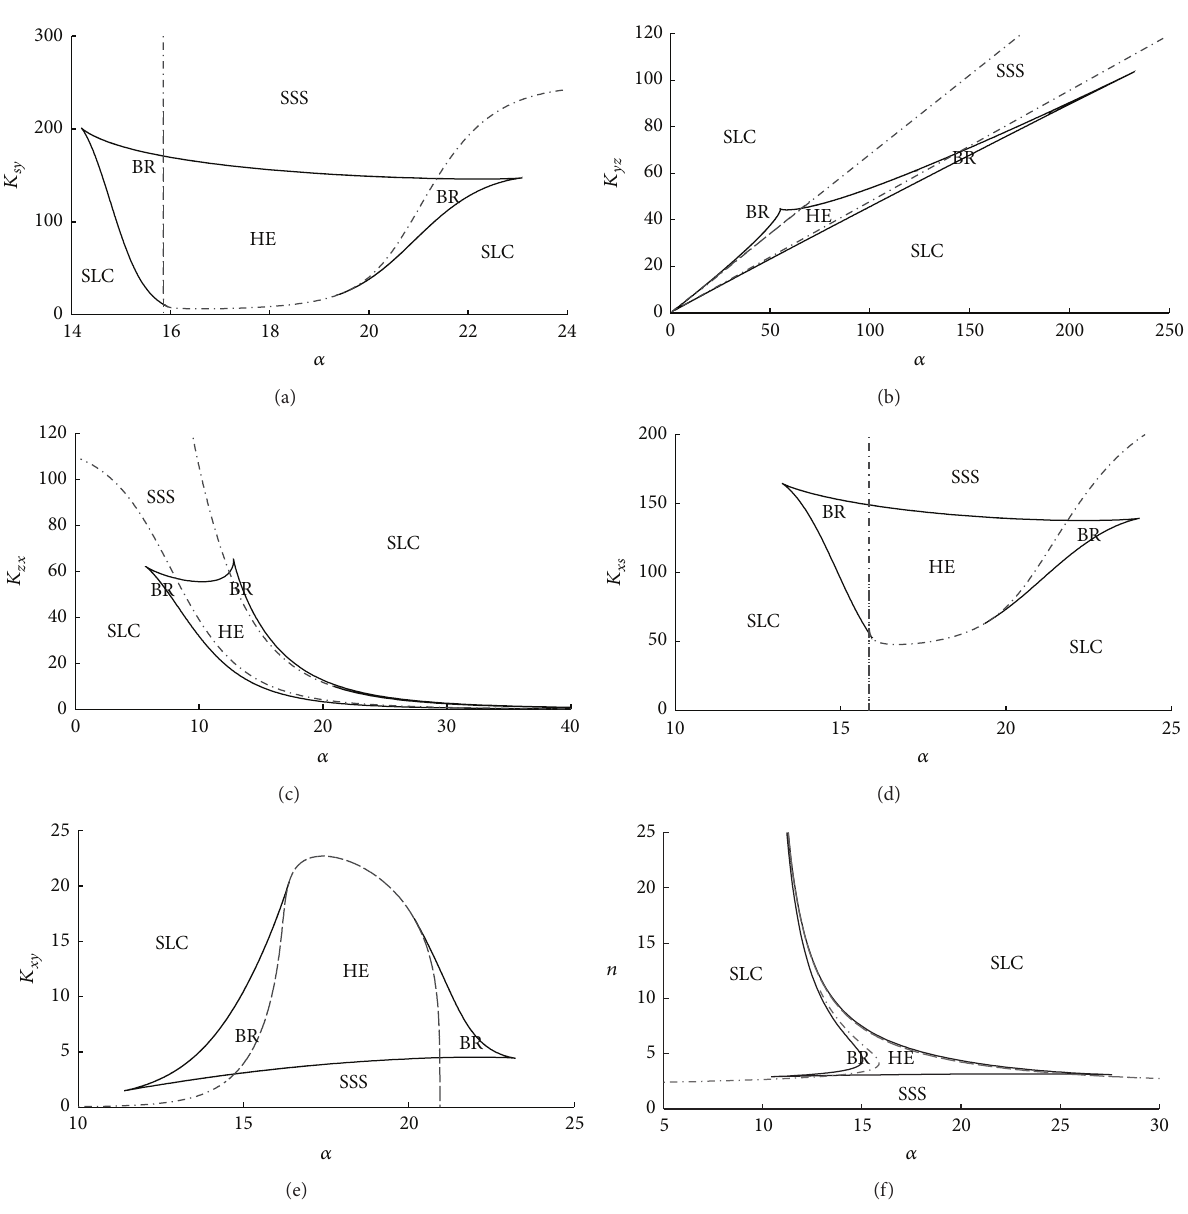
Figure 7: Bifurcation diagram of parameter 𝛼 versus parameters 𝐾 𝑠𝑦 , 𝐾 𝑦𝑧 , 𝐾 𝑧𝑥 , 𝐾 𝑥𝑠 , 𝐾 𝑥𝑦 , and 𝑛 for model